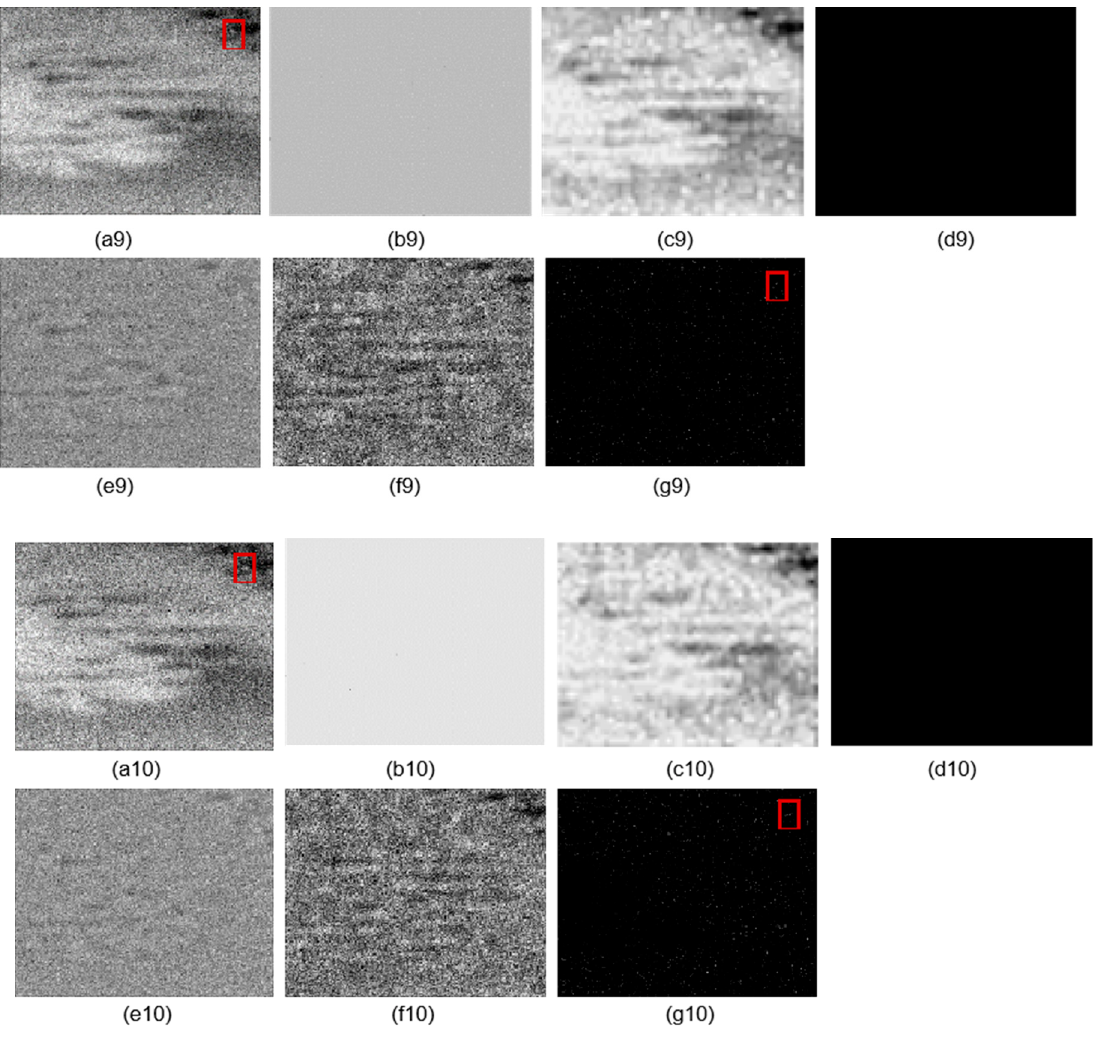
Figure 8. 2D images of ten sequences and corresponding results. ( a1 – a10 ) The original image; ( b1 – b10 ) IPI; ( c1 – c10 ) ILCM; ( d1 – d10 ) NRAM; ( e1 – e10 ) WTRPCA; ( f1 – f10 ) Tophat; ( g1 – g10 ) OURS.